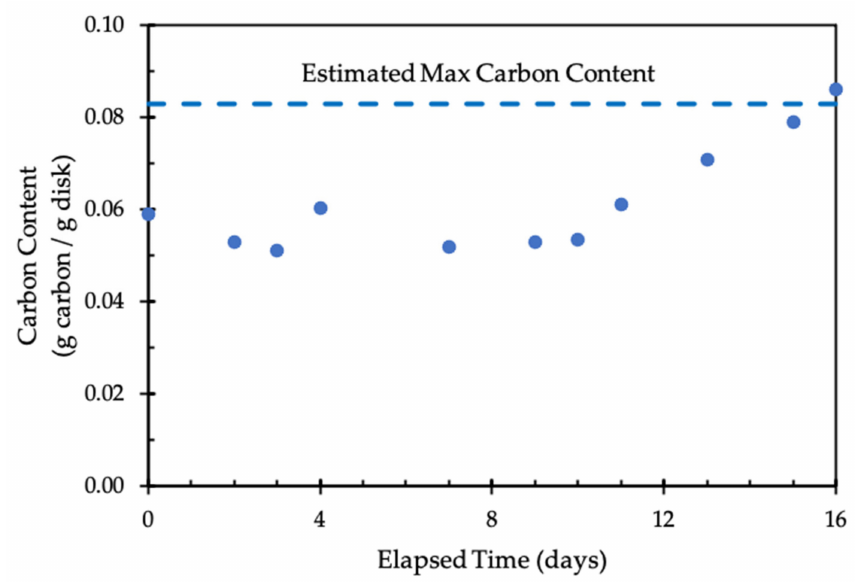
Figure 5. Change in the carbon content in the disks of Tail 2a. The maximum carbon content is estimated based on all of the labile calcium and magnesium measured in the flow-through dissolution experiment being converted to calcite and magnesite,